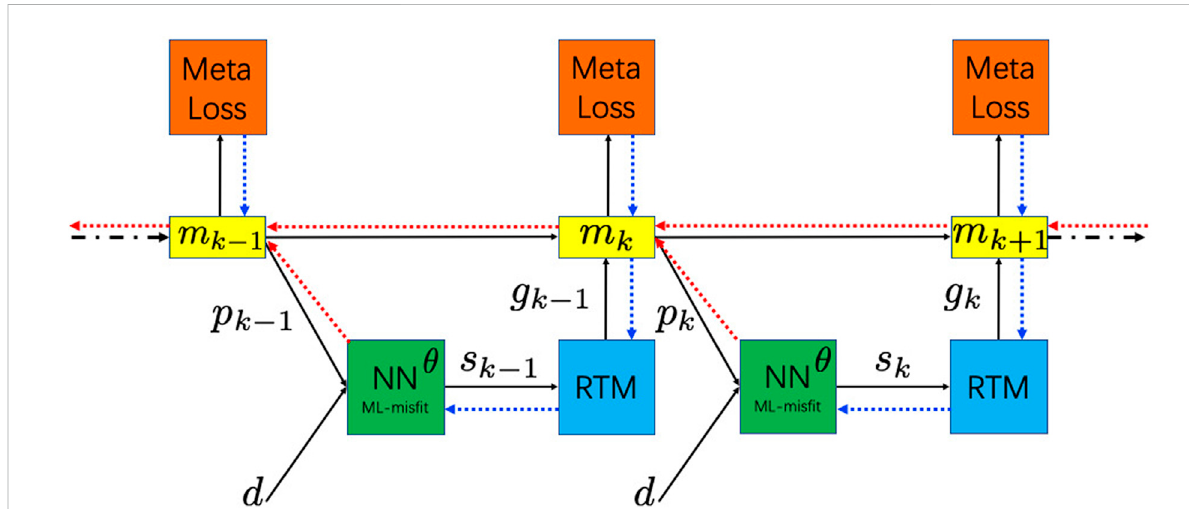
FIGURE 2 Schematic plot describing the fl ow for the FWI using the ML-mis fi t function. The green block is the neural network with parameters θ representing the ML-mis fi t function. The blue block represents the adjoint operator [reverse time migration (RTM) operator]. The red block refers to thecomputationofthemeta-lossde fi nedbyEq.5.Theyellowblockdenotes thevelocitymodel m k . p k isthepredicteddatamodeledbythevelocity modeland d isthemeasureddatasets. s k istheadjointsourcecomputedfromtheML-mis fi t. g k isthegradientoutputfromtheRTMblockgiven anadjoint source s k .The blueandredcurves denotethegradient fl owfor updating parameters θ for theML-mis fi t.Thebluecurvesarerelated tothe fi rst-order dependency between the meta-loss and the parameters θ , while the red curves correspond to higher-order